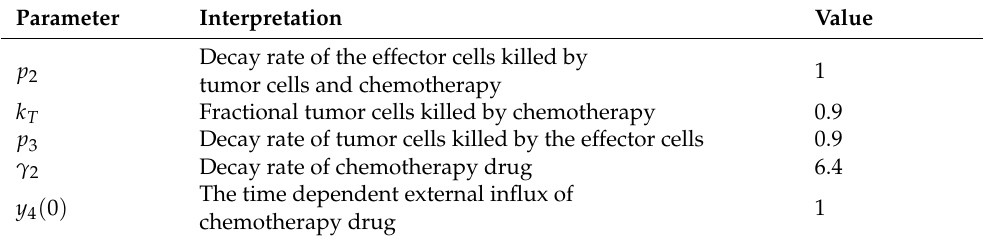
Table 2. Cont . Parameter Interpretation